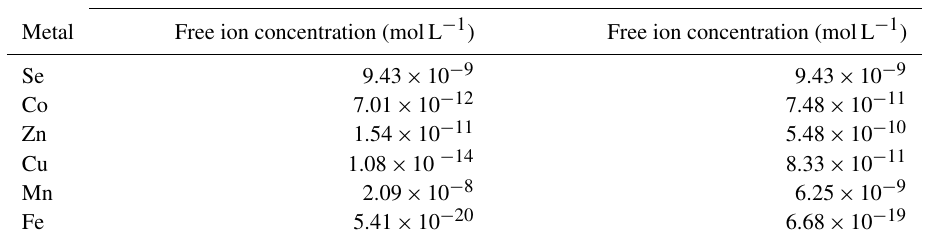
Table A1. The bioactive concentration of trace metals in different media calculated with Visual MINTEQ 3.1. Total ion concentrations of each trace metal from the original natural seawater and Aquil media were measured using seaFAST system. The free ion concentrations were calculated based on the total ion concentrations from natural seawater or ultra-pure water, together with the added concentration during the experiment. Temperature = 17 ◦ C; pH8.1; ionic strength = 0.7.